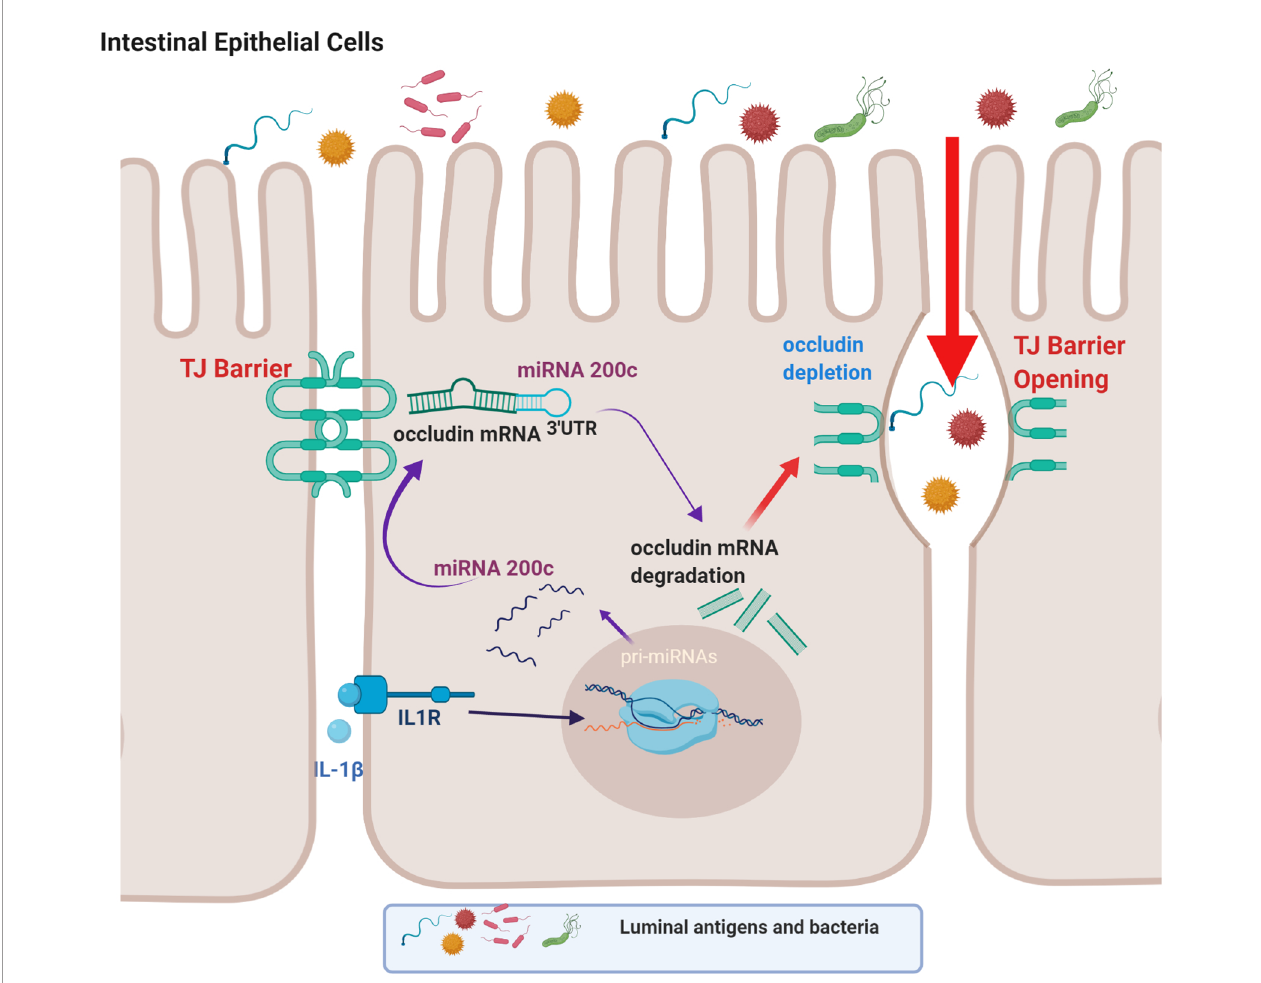
FIGURE 2 | Schematic diagram showing the involvement of the microRNA-200c-3p-induced degradation of occludin mRNA in interleukin-1 b (IL-1 b )-induced increase in intestinal epithelial tight junction permeability. (Created with